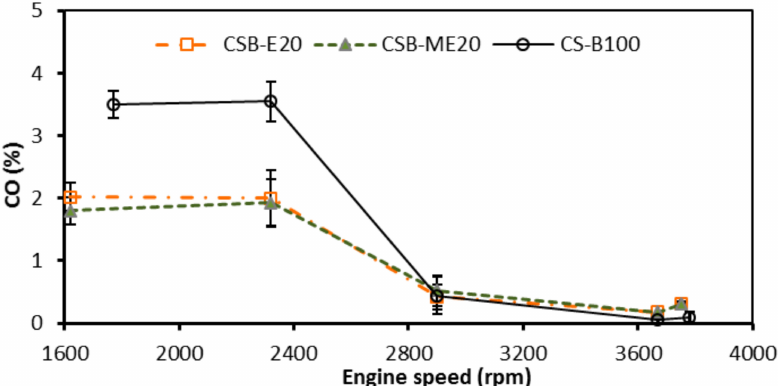
Figure 12. The relationship between engine speeds (rpm) and CO (%) for CS-B100, CSB-E20 and